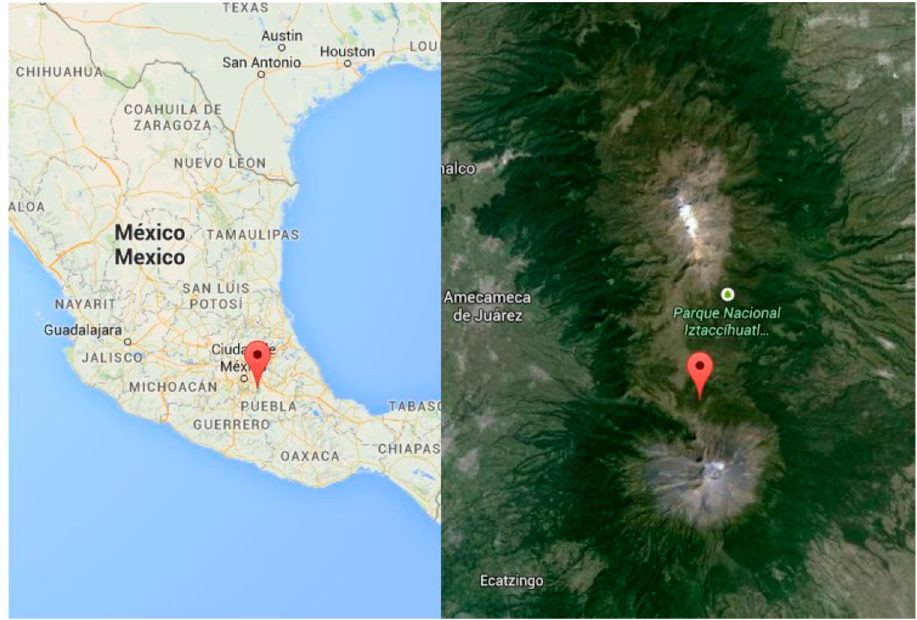
Figure 1. Location of volcano Popocatepetl and Tlamacas observational site (https://www.cenapred.unam.mx/reportesVolcanGobMX/ (accessed on 15 December 2022)).